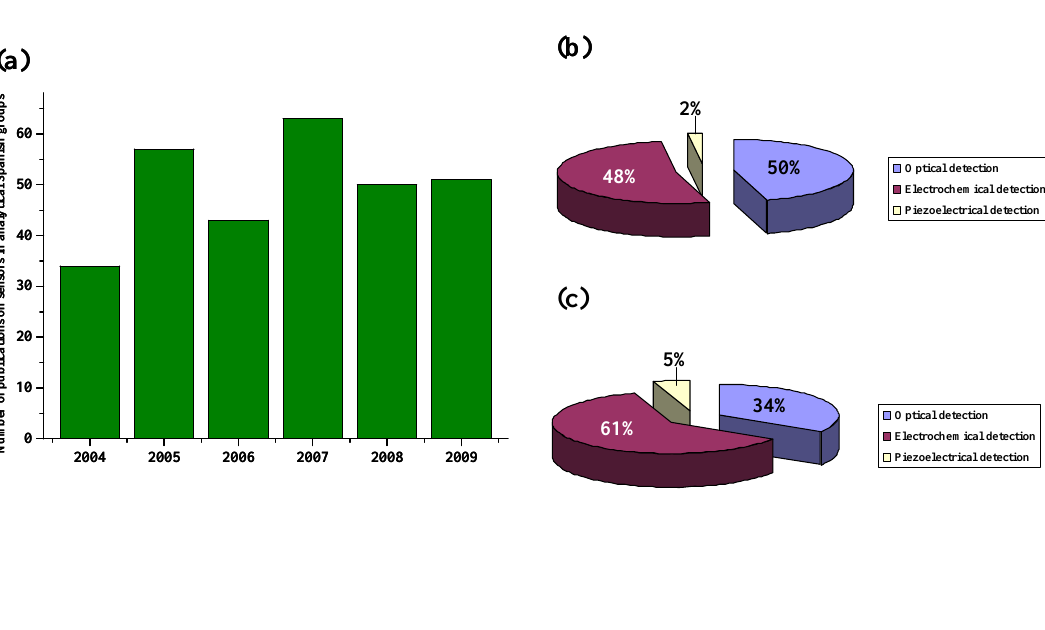
Figure 1. (a) Number of publications on sensors from analytical Spanish groups during 2004–2009. Distribution of publications according to the type of transduction used in Spanish (b) and international (c) analytical